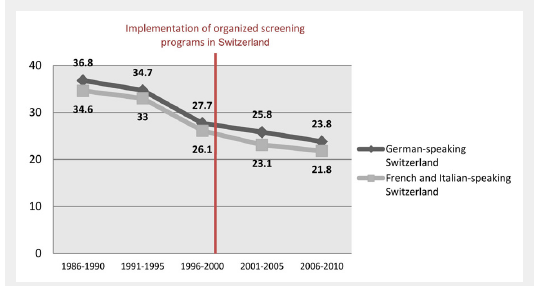
Breast cancer mortality rates by region over time (all women). Death rates per 100'000 are age standardised using the European Standard Population. The introduction of the mammography screening programme does not seem to modify the mortality rate, which had been progressively declining since 1990. Source: Swiss Federal Statistical